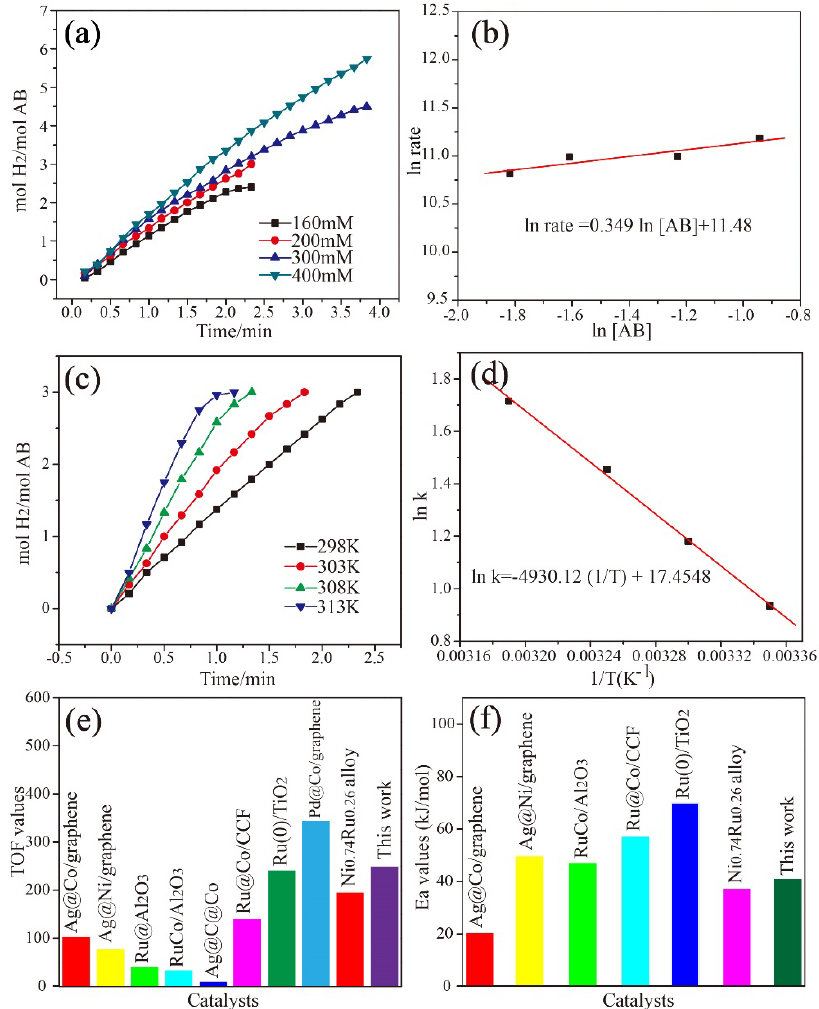
Figure 4. ( a ) The plots of mol H 2 /mol AB versus reaction time at different AB concentrations. ( b ) Plot of ln (rate) versus ln [AB]. ( c ) The plots of mol H 2 /mol AB versus time for different temperatures. ( d ) The Arrhenius plot for the hydrogen release of AB. ( e , f ) Comparison of TOF values and E a values among this work and the reported